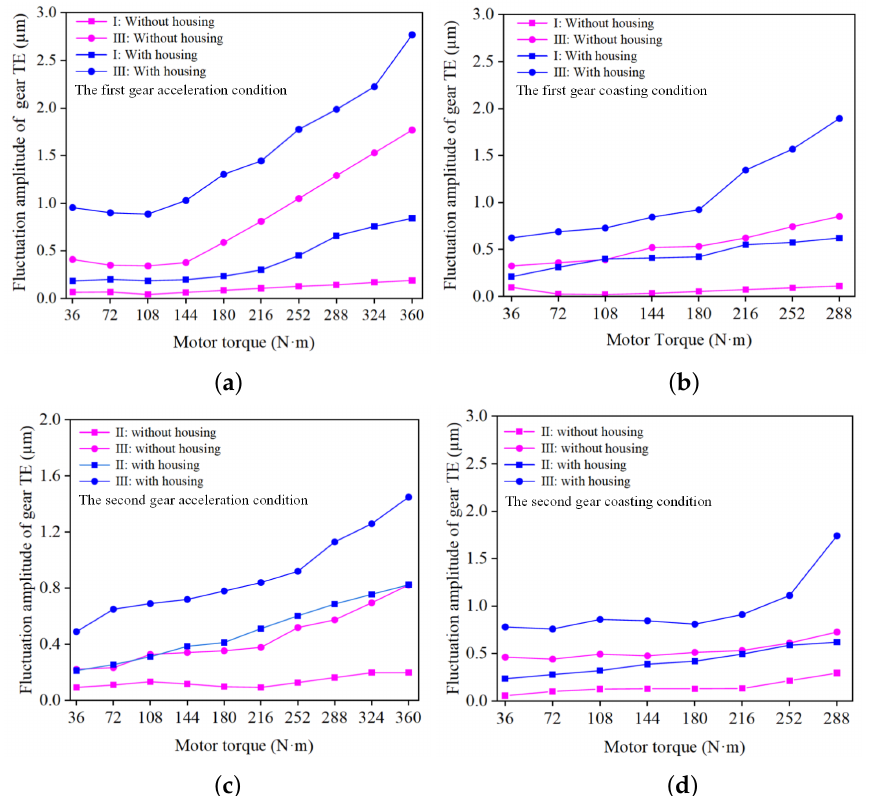
Figure 8. The TE of the system before and after the introduction of the gearbox housing were compared and analyzed. ( a ) Fluctuation amplitude of gear TE under the first gear acceleration condition. ( b ) Fluctuation amplitude of gear TE under the first gear coasting condition. ( c ) Fluctuation amplitude of gear TE under the second gear acceleration condition. ( d ) Fluctuation amplitude of gear TE under the second gear coasting